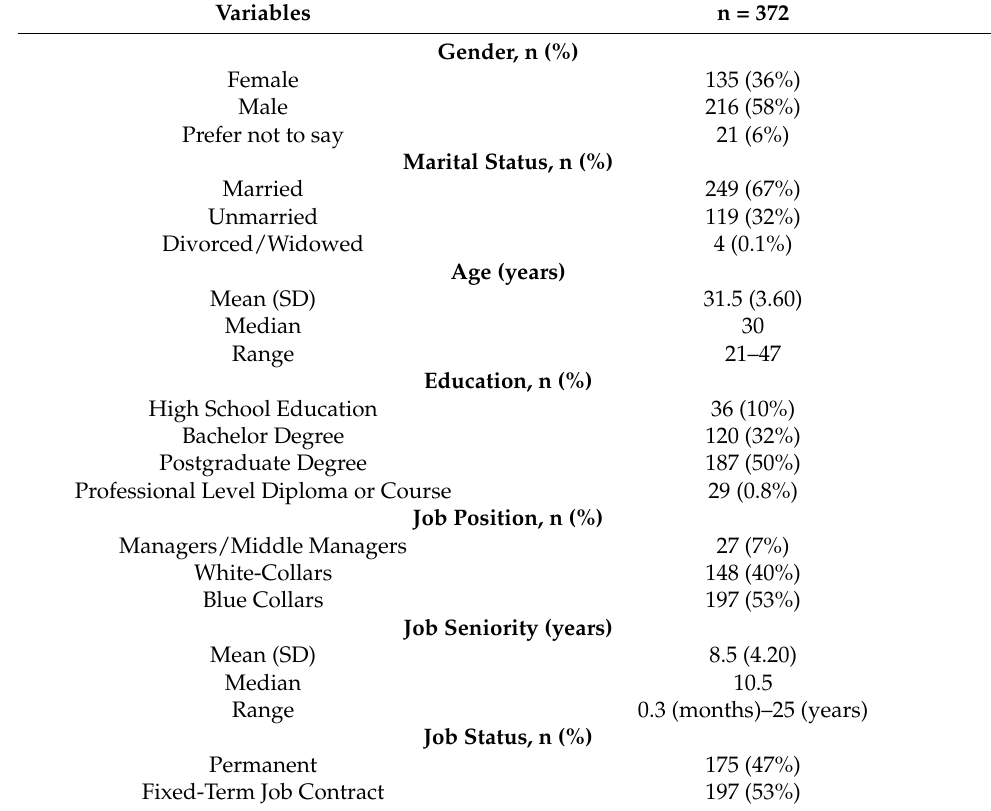
Table 1. Socio-demographic data (n =